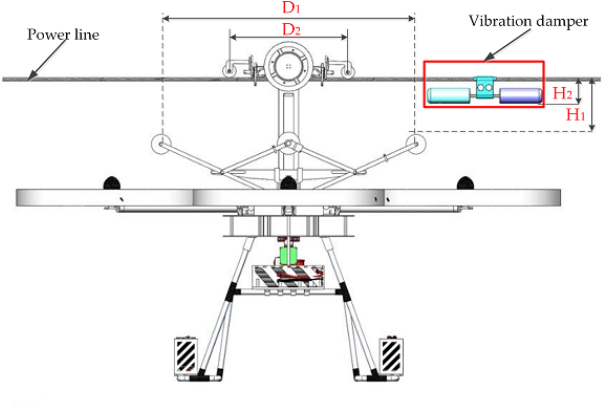
model of the pressing component is shown in Fig. 10a. An axis system is created at the O position, with its x axis point- ing in the horizontal direction and its y axis vertical to the x axis in Fig. 10a. The pressing component is symmetric about the y axis in Fig. 10a. Thus, it is analyzed to the right half of the y axis of the pressing component in Fig. 10b to e. the number of unknown forces in the moment